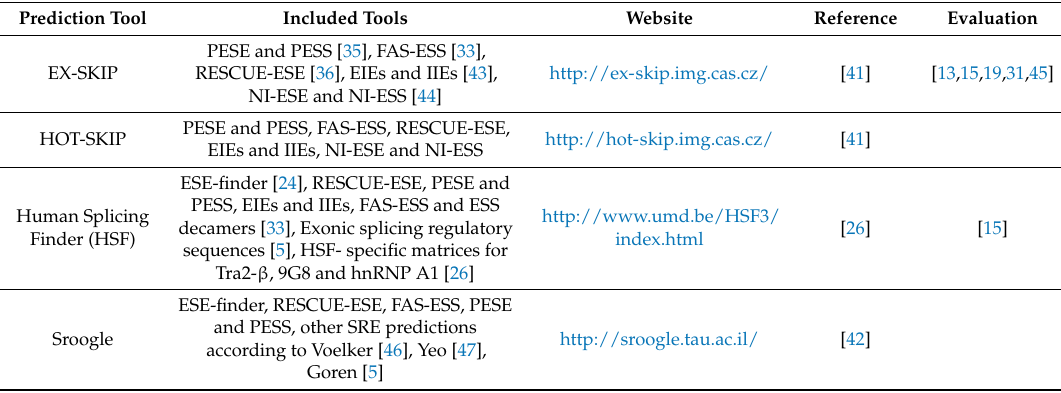
Table 2. Selected tools and online engines combining multiple SRE-prediction